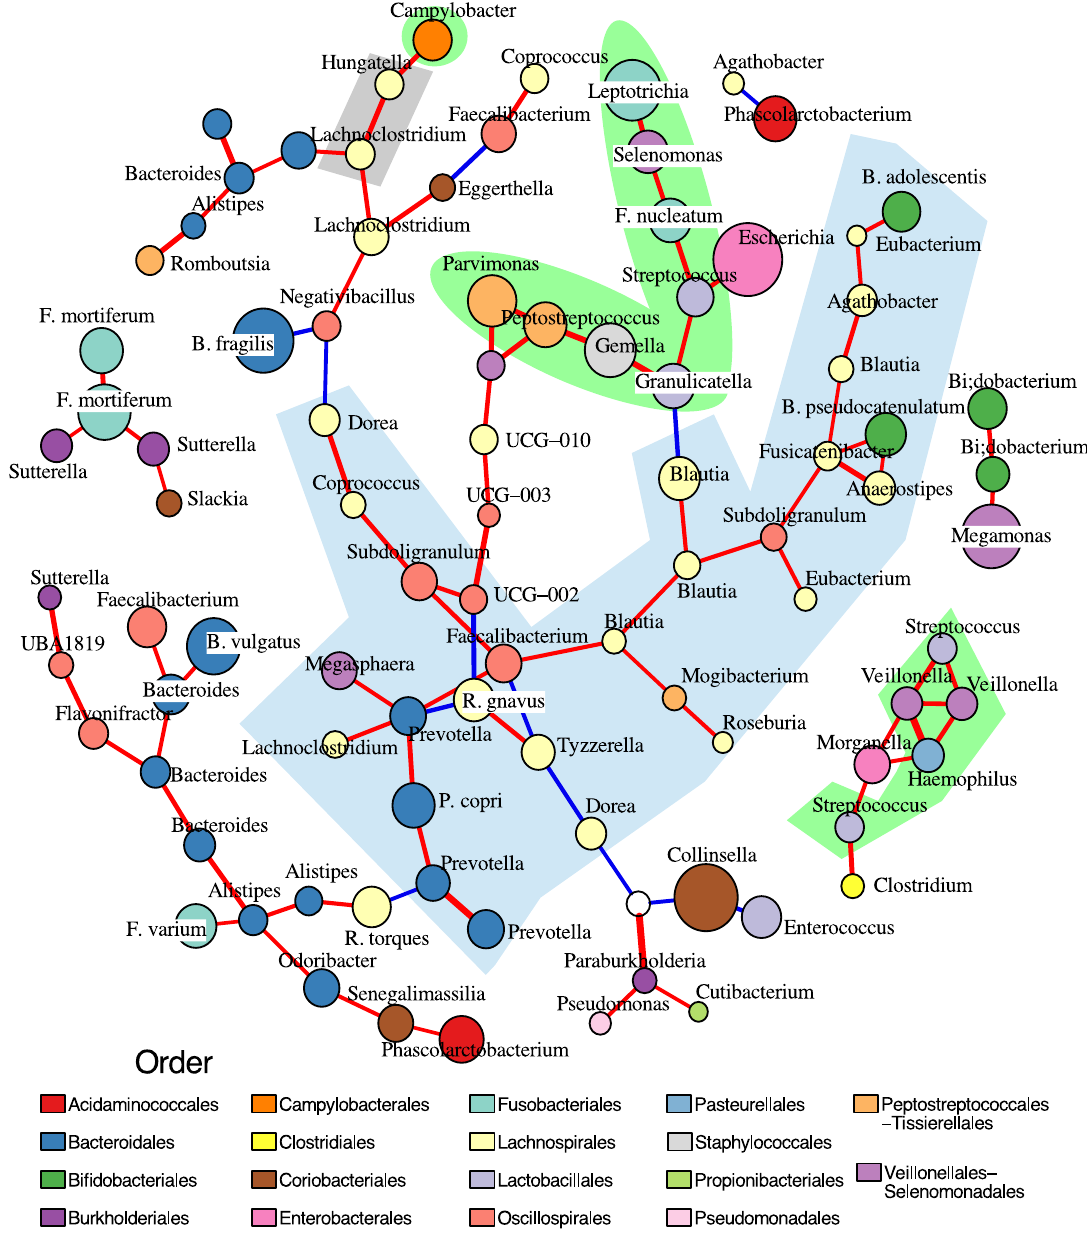
Fig. 3 Correlation network of colorectal cancer gut mucosal microbiomes. The network was constructed from 117 most representative ASVs sampled from 86 mucosal microbiomes, outlining signi fi cant interactions detected by both CCLasso ( p value ≤ 0.01 and absolute correlation strength > 0.37) and SpiecEasi. Positive and negative interactions were coloured as red and blue lines respectively, with line weight proportional to correlation strength. The ASVs (nodes) were coloured based on taxonomic family (see Legend), with sizes proportional to their relative abundances. The light green shaded area entails ASVs identi fi ed as members of the human oral microbiome (comparison with expanded Human Oral Microbiome Database); the blue shaded area covers ASVs identi fi ed as gut anaerobic commensals (Lachnospirales, Bacteroidales, Bi fi dobacteriales, Oscillospirales); and gray shaded area covers other tumour-associated ASVs (as identi fi ed in Fig. 2a). Source data are provided as a Source Data fi